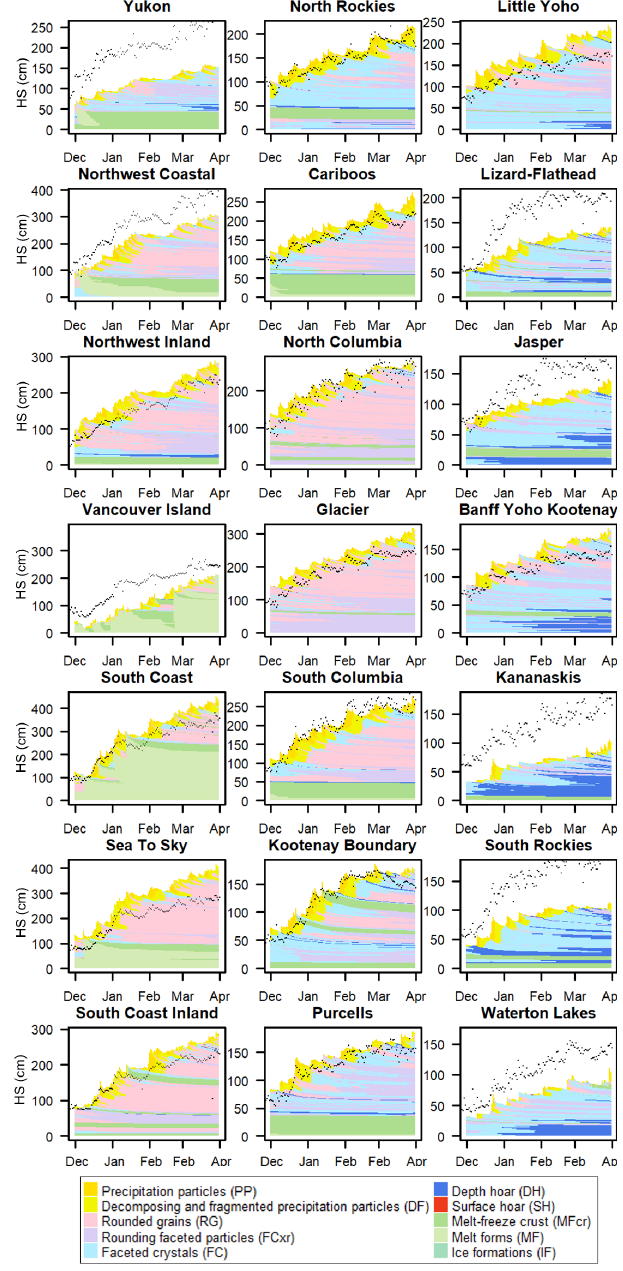
Figure 8. Simulated snowpack structure at a representative location in each forecast region with the snow depths from upscaled observa- tions shown with black squares. Snowpack layers are colour-coded by grain type following Horton et al.